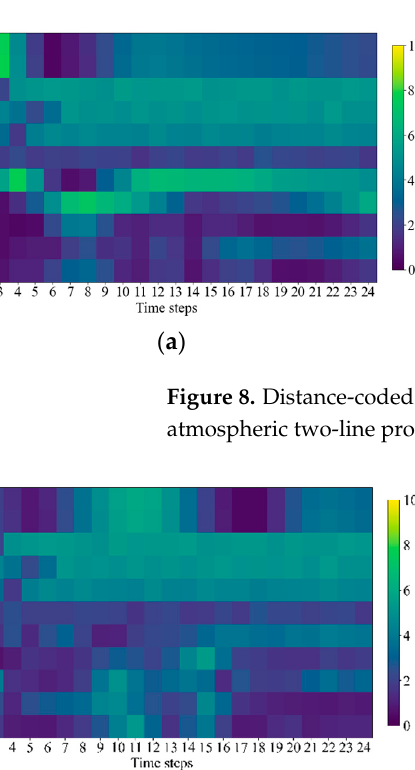
Figure 7. Distance-coded heat map of working condition 1. ( a ) Heat map of operating parameters of atmospheric two-line products. ( b ) Heat map of operating parameters of vacuum two-line products.